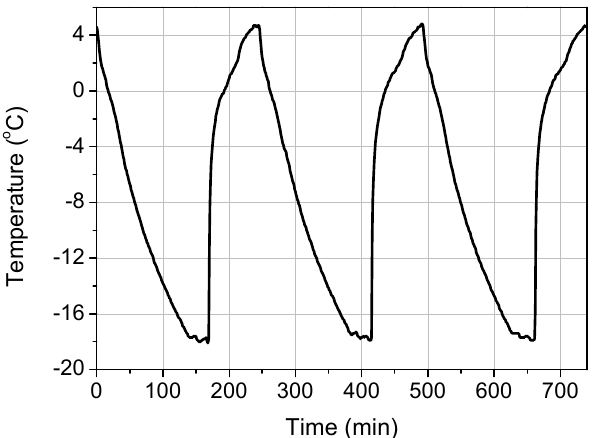
Figure 4. Temperature inside the TRM overlay versus time during freeze–thaw cycling.